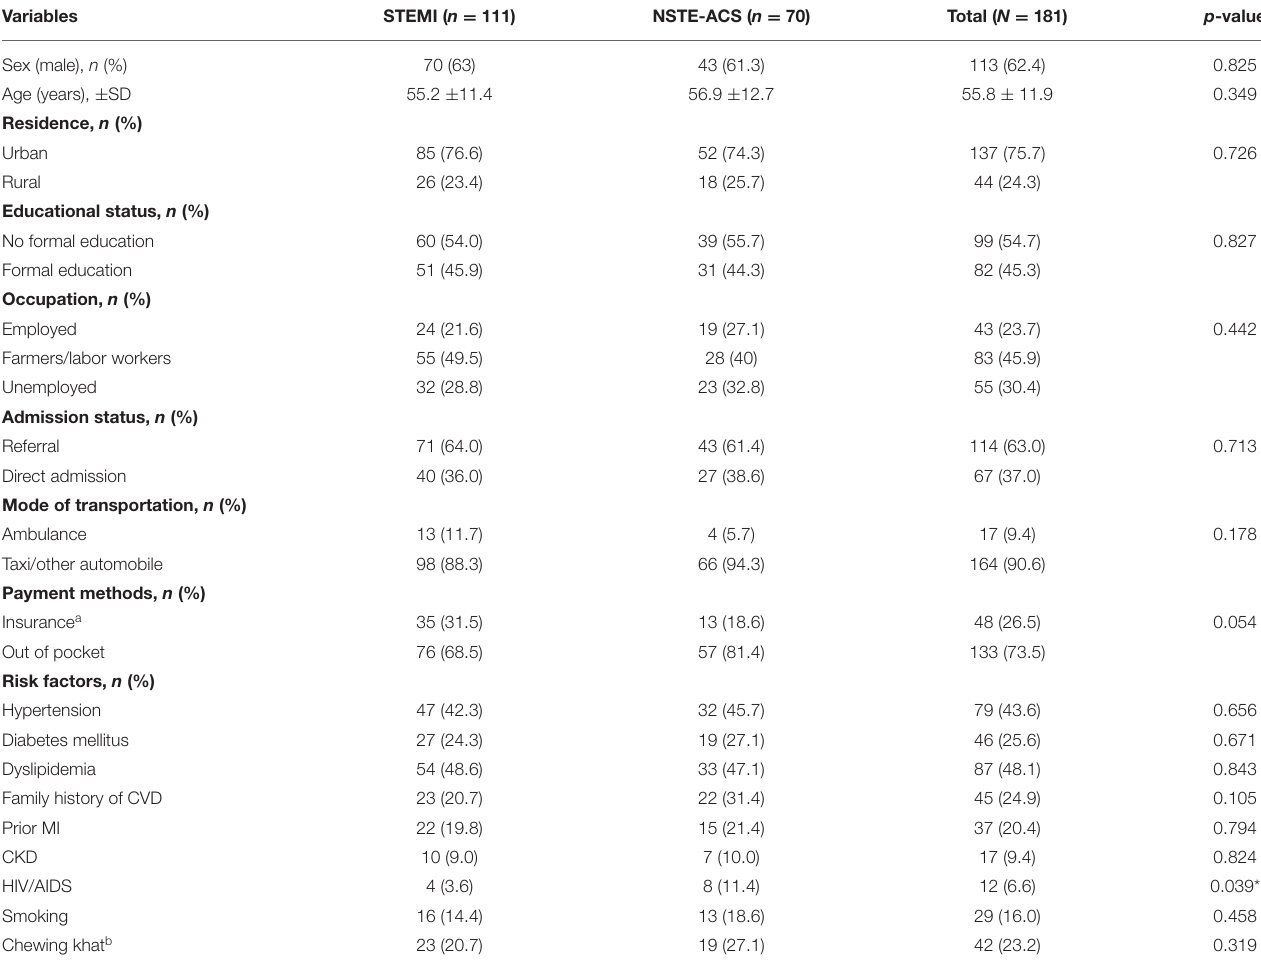
TABLE 1 | Baseline clinical characteristics of the study participants by ACS subtype. Variables STEMI ( n = 111) NSTE-ACS ( n =